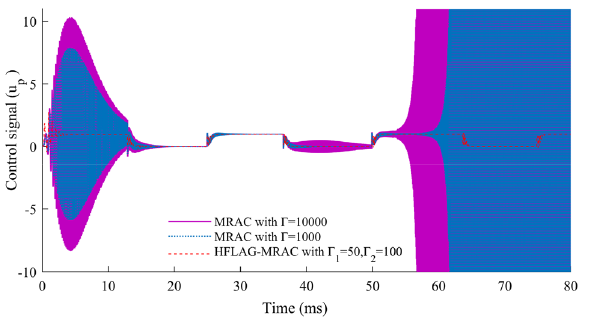
Figure 20. Control signal comparison of the proposed HFLAG-MRAC with other control schemes under varying solar insolation.